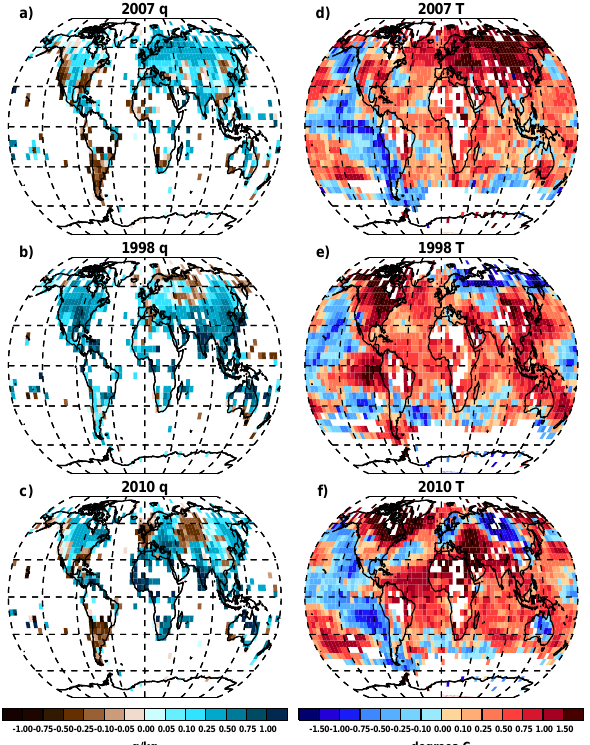
Fig. 14. Annual average anomalies (from the 1976–2005 clima- tology period) for HadISDH specific humidity and HadCRUT4 (Morice et al., 2012) temperature for the two moistest years within the HadISDH record (1998 and 2010) which were also among the warmest years since records began in 1850, and one of the warmest years in the land record from CRUTEM4 (2007: see Fig. 13) that was not simultaneously very moist. Note non-linear colour